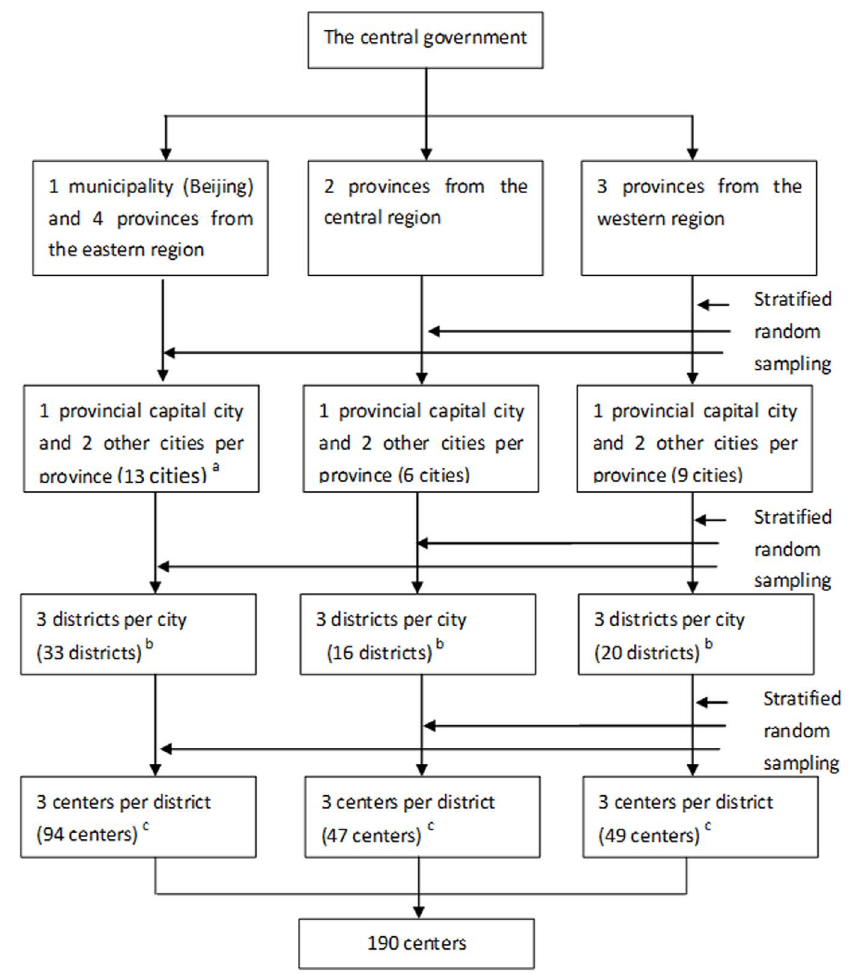
Fig. 1. Sampling flow of community health services centers. a: Beijing is a municipality with no affiliated city. Dalian is selected in Liaoning province instead of its capital city, because it is one of the five cities (Xiamen, Ningbo, Qingdao, Shenzhen, and Dalian) specially designated in the state plan which is similar in size and economic situation to a provincial capital. b: It is plan to sample 3 districts per city in the design, while some cities selected had less than 3 districts. c: It is plan to sample 3 centers per district in the design, while some districts selected had less than 3 centers.